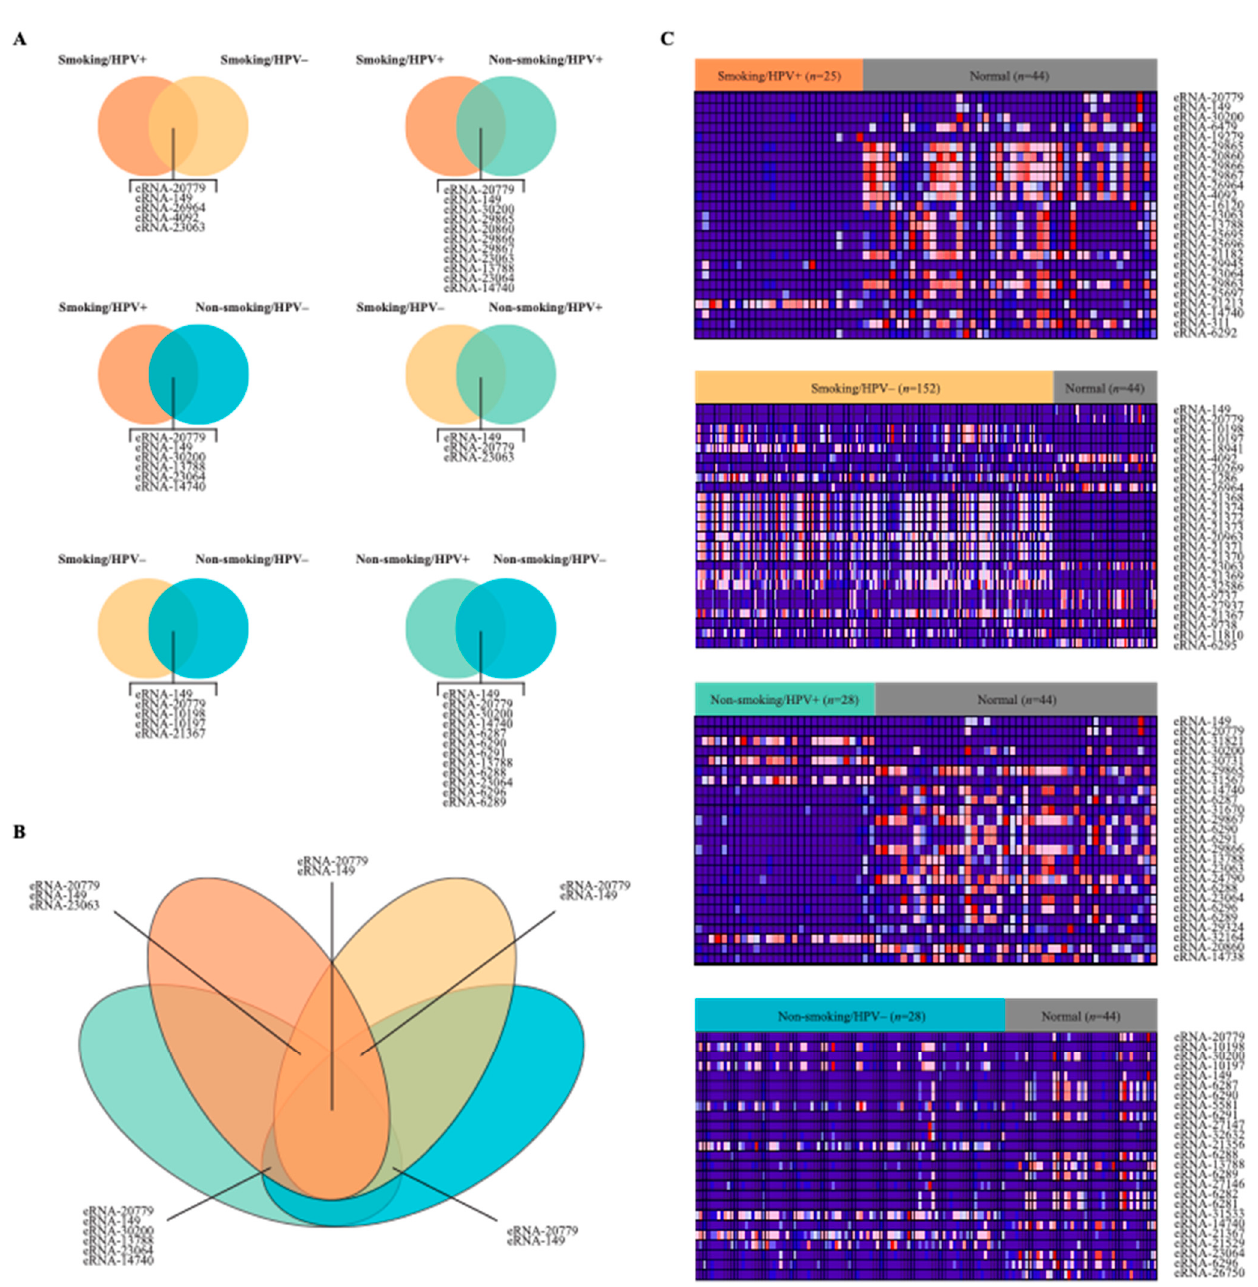
Figure 2. Summary of Differential Expression of eRNA in patient cohorts. ( A ) Two-way Venn diagrams comparing differentially expressed eRNA (top 25) in patient cohorts. ( B ) Four-way Venn diagram displaying differentially expressed eRNA (top 25) common to patient cohorts. ( C ) Heatmaps, each displaying the top 25 differentially expressed eRNA between the patient cohort and normal samples. The number of samples per cohort is displayed as n = values. Blue represents a low expression of eRNA, and red represents a high expression. Differentially expressed eRNAs were considered significant if they had a p -value < 0.05 and |log (FC)| >